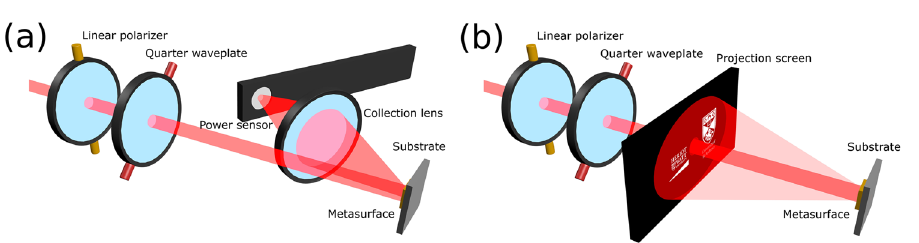
Figure 2. Schematic of the fabrication process and the fabricated flexible MS hologram. ( a ) A silicon substrate is initially coated with an Omnicoat layer and a thick SU-8 film by spin-coating. ( b ) A gold film is evaporated onto the SU-8 film as a reflective backplane. After that, a spacing layer of SU-8 is then spun onto the gold film. Finally, a second gold film is deposited on the SU-8 film. ( c ) A resist layer of SU-8 is spun onto the final gold layer for the standard electron beam lithography process. Nanorods are defined after the development process and then used as the etching mask. ( d ) Gold nanorods on the top of the sample are then obtained after a reactive ion etch. The Omnicoat layer is then dissolved to leave a free-floating flexible hologram. ( e ) An SEM image of a typical area of the nanorod MS taken after lift-off. It was observed that there were no discernible visual differences between the SEM images of the sample before, and after lift-off (see Supplementary Fig. S1).